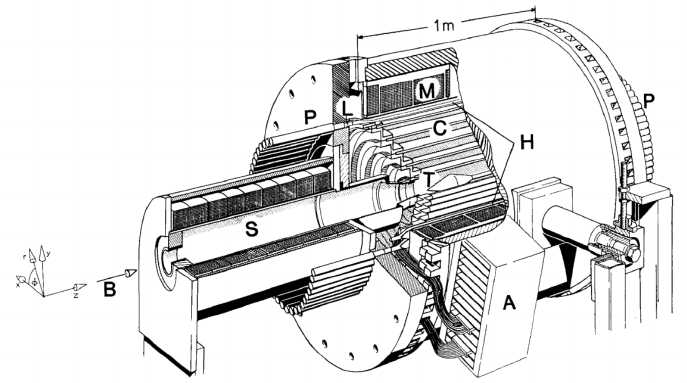
Figure 14. Schematic of the SINDRUM experiment. B, muon beam; S, focussing solenoid; T, target; C, five cylindrical multi-wire proportional chambers; H, hodoscope of 64 scintillators; L, light guides for the hodoscope; P, 128 photomultipliers; A, preamplifiers for the cathode strips and amplifier/discriminators for the anode wires; M, normal conducting coil of the magnet. Figure and caption from [165].